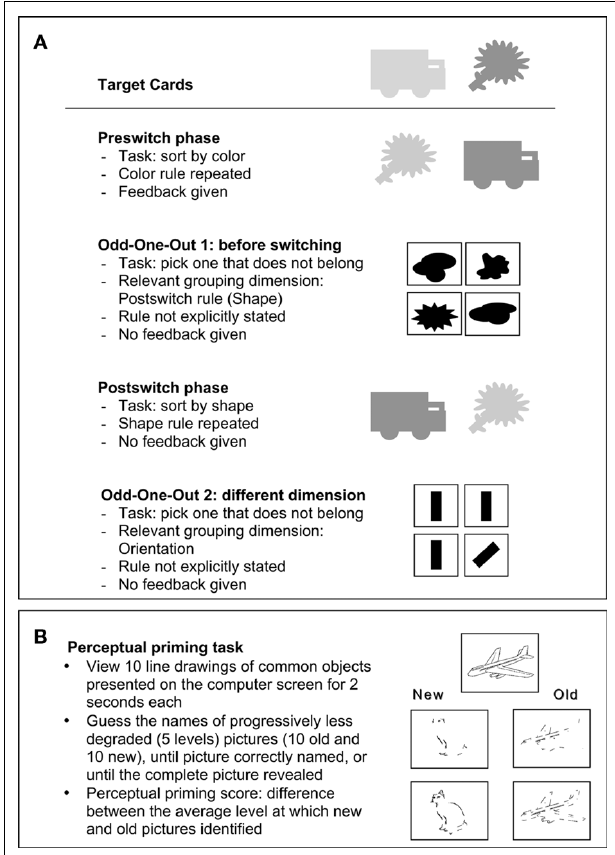
FIGURE 1 | (A) Dimensional Change Card Sort and Odd-one-out tasks:The DCCS sorting cards are shown under the corresponding target cards, for a sample preswitch and postswitch. (B) Perceptual priming task: Pictures were presented in a random, but constant order. “Old” and “new” lists were counterbalanced, and constructed such that each list contained the same number of items from various categories, such as animals and household